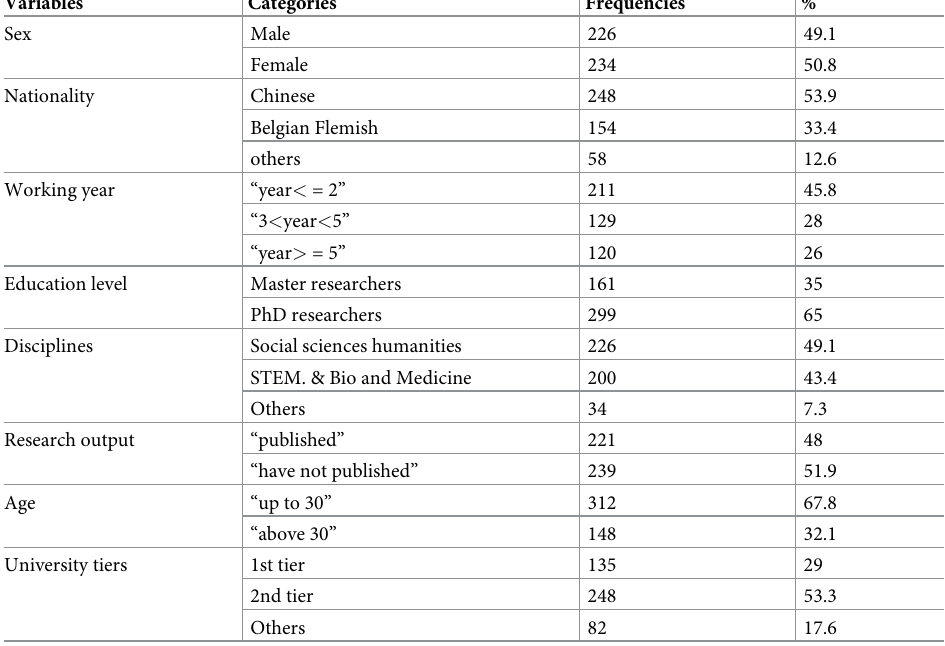
Table 1. Demographical profile of research